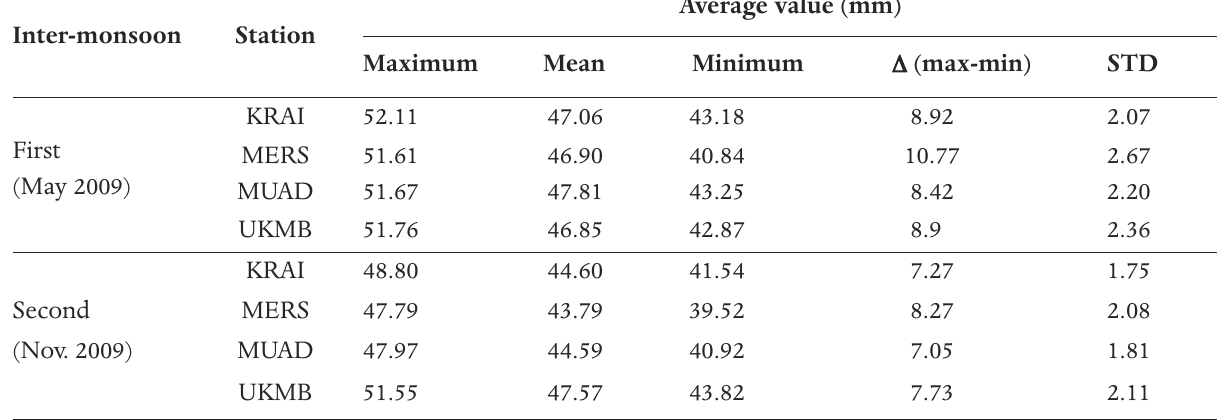
Table 4. The comparison of GPS PWV during two inter-monsoons at four selected